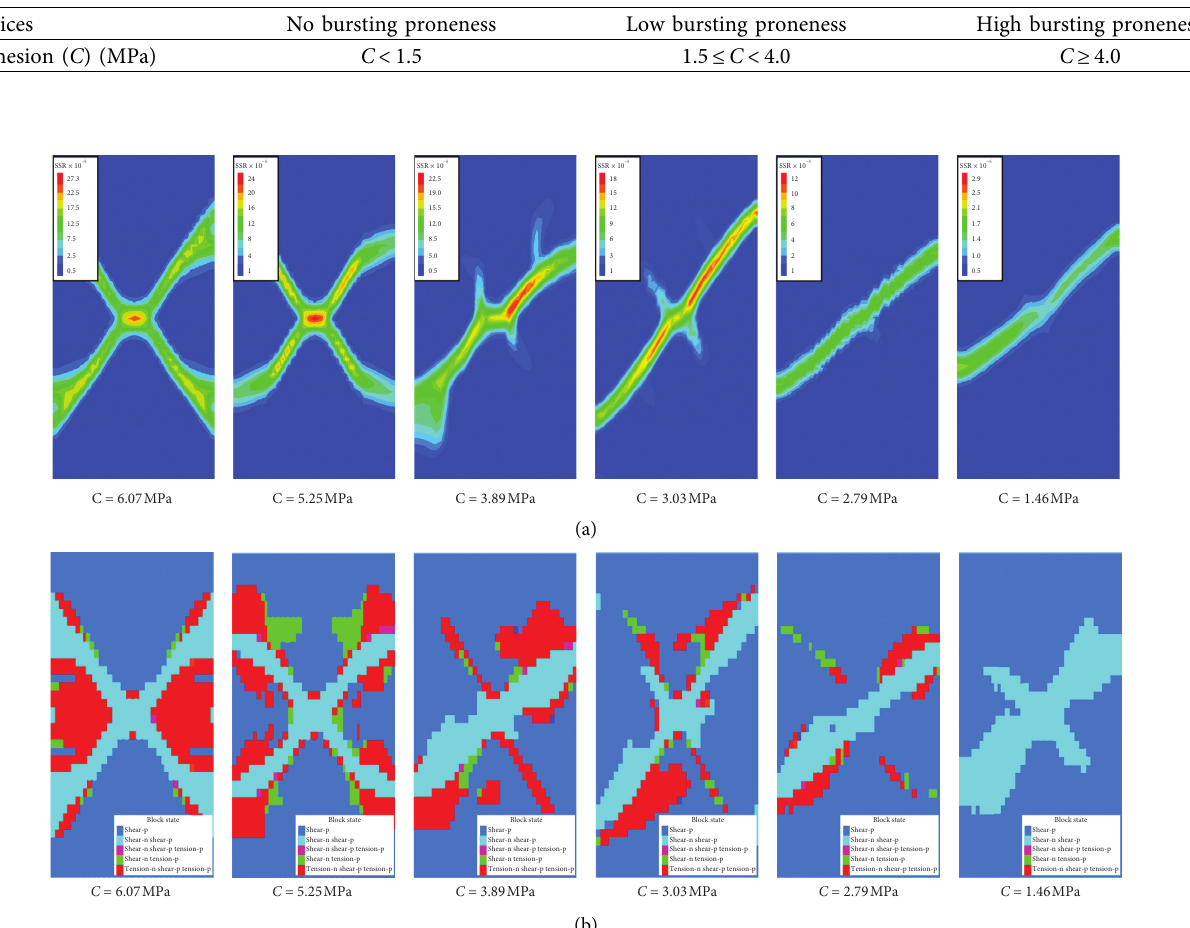
Table 8: Cohesion used to identify the bursting proneness of